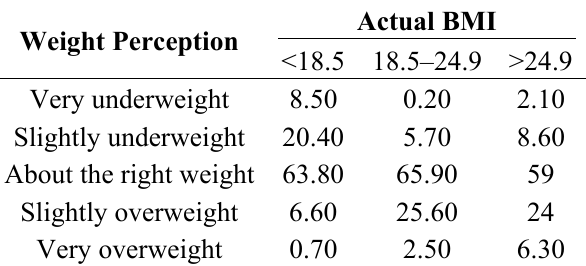
Table 1. Weight perception and actual BMI